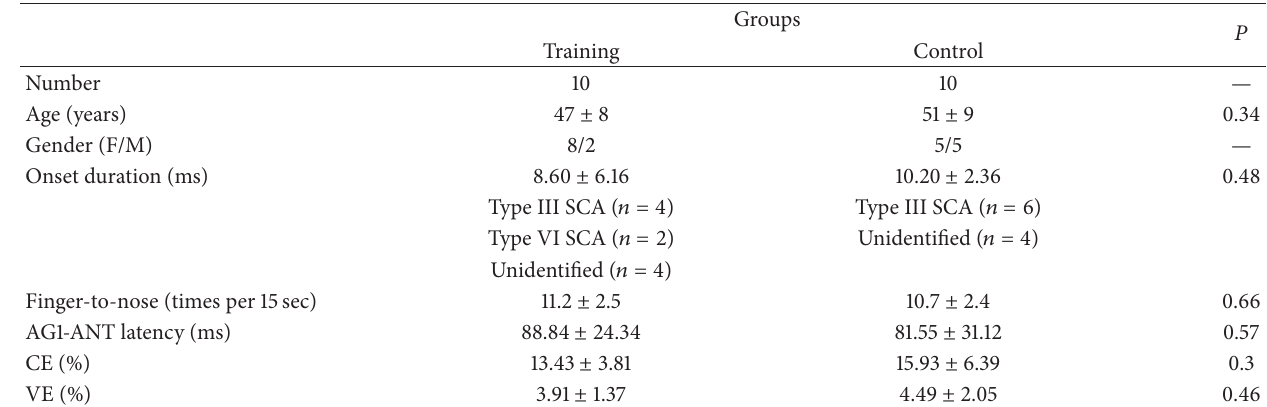
Table 1: Basic data of the